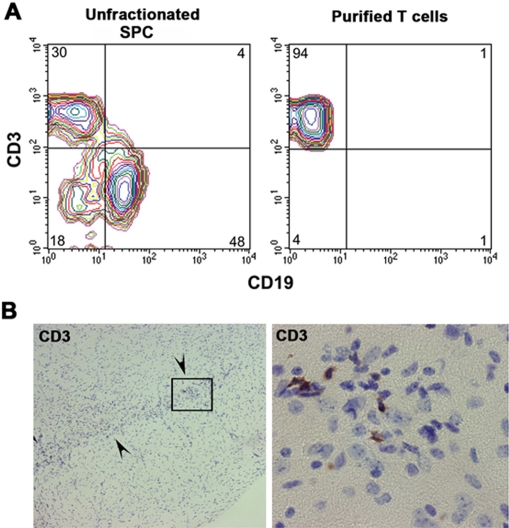
Adoptive transfer of SPC and purified T cells from N-4YSyn vaccinated B10.BR donors leads to infiltration of T cells in the SNpc of MPTP mice on day 2.(A) Frequency of CD3+ T cells and CD19+ B cells before and after enrichment of T cells. Population of enriched T-cells was 94% CD3+ prior to adoptive transfer to B10.BR mice. (B) Sections throughout the SNpc were immunostained for CD3 and counterstained with thionin. Clusters of CD3+ cells are observed within the SNpc (arrowheads) as seen at 100× magnification (left). Magnification (600X) of boxed area (left panel) is shown (right panel). CD3+ cells are small and round exhibiting lymphocyte morphology.